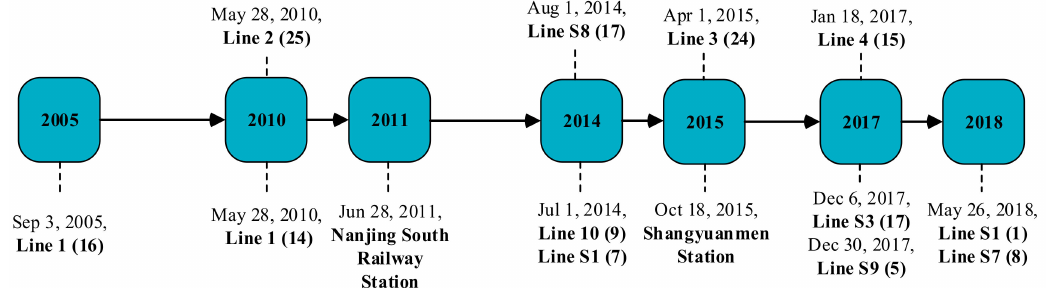
Figure 2. The timeline of Nanjing’s subway development. Notes: The number in parentheses denotes the number of stations. Nanjing South Railway Station opened accompanied by the opening of Beijing–Shanghai high-speed railway (HSR) in 2011, which has been the most important traffic hub in Nanjing. The opening of Shangyuanmen Station in Line 3 was delayed due to the engineering construction.